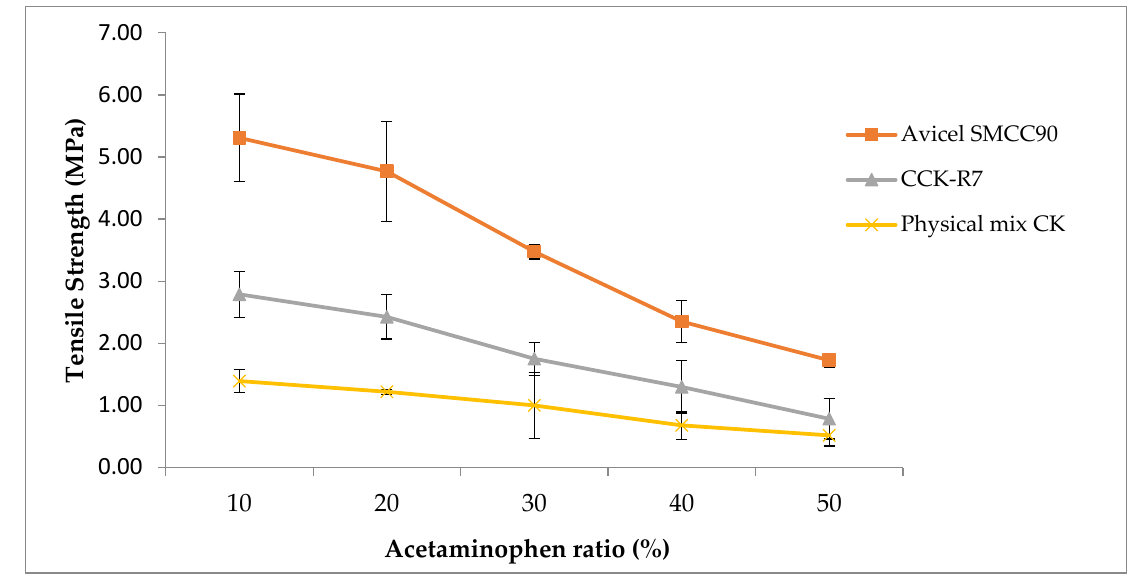
Figure 8. Tablet tensile strength versus the percentage of acetaminophen using Avicel SMCC90 ® , CCK-R7, and the physical mixture of chitosan and kaolin.